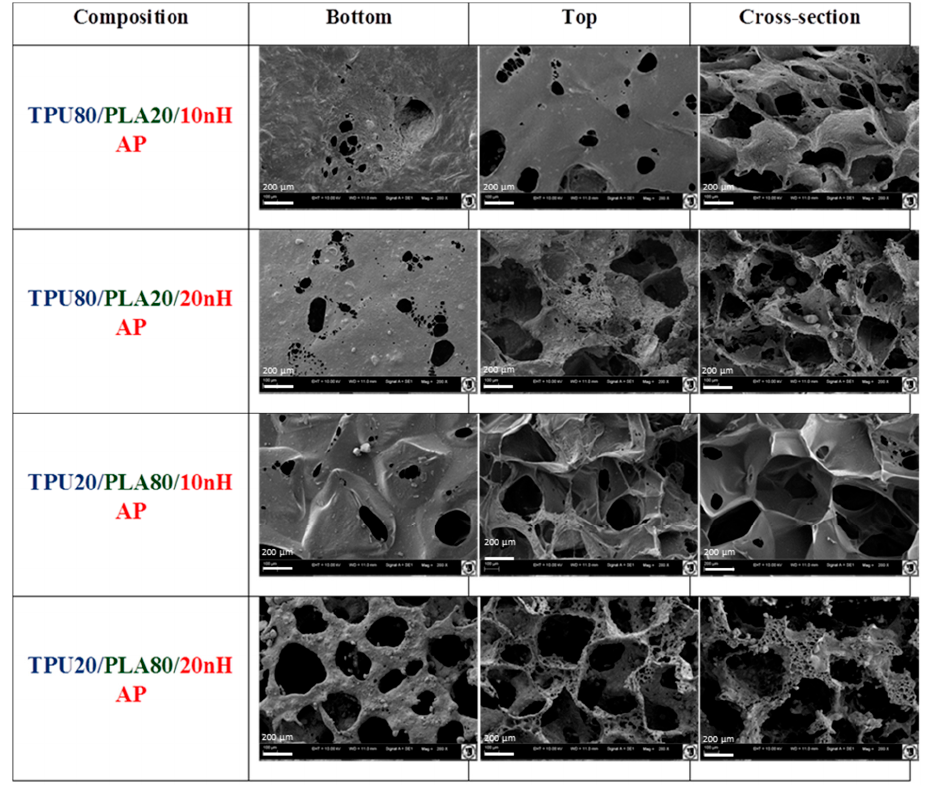
Figure 2. SEM images of the surfaces and cross-sections of TPU/PLA/nHAP sponges, magnification 200×, scale bar = 200 µm. 200 × , scale bar = 200 µ